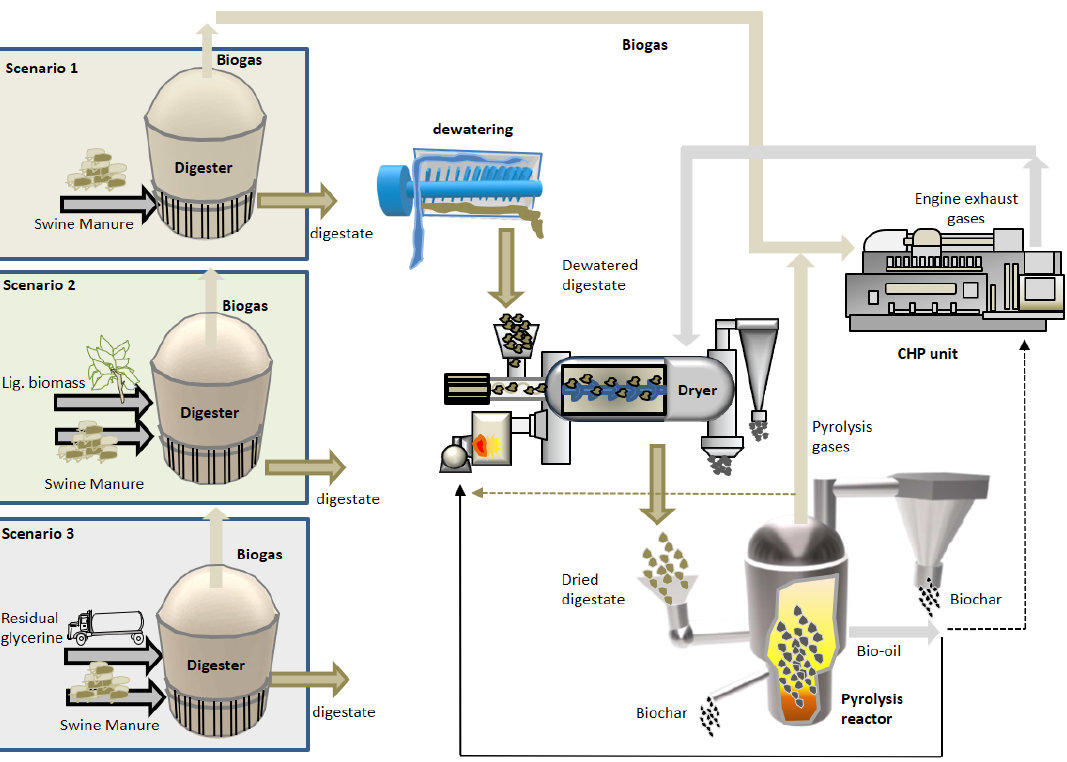
Figure 1. Schematic representation of the integrated approach for waste valorizations. The digestion of manures in the first treatment stage and pyrolysis of the digestate in a subsequent stage.